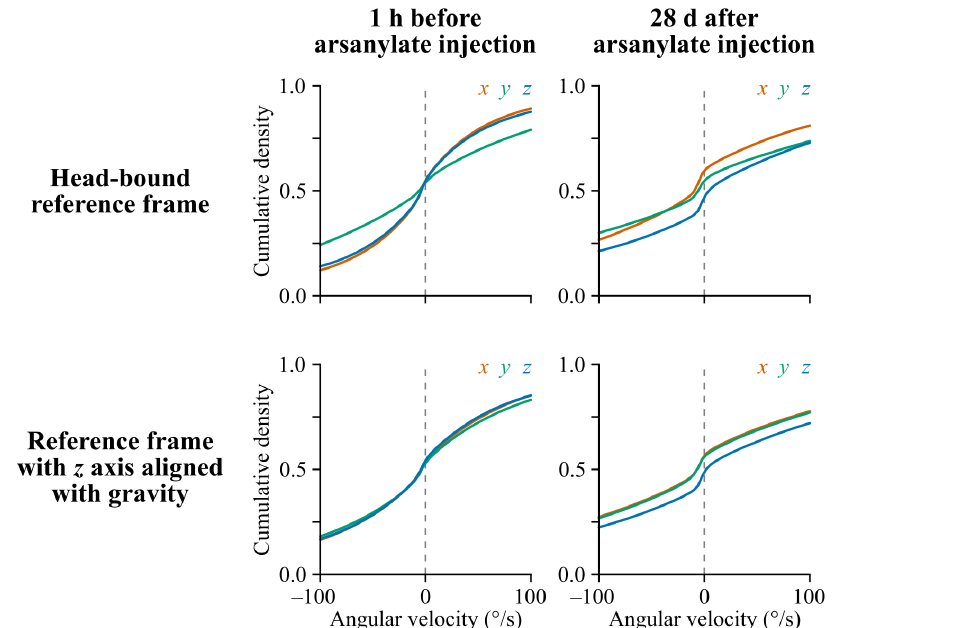
Figure A5. Per axis cumulative angular velocity distributions in a head-bound vs. a gravity-aligned reference frame before and after arsanilate injection into the left inner ear (example from one rat). In basal conditions, the distribution of pitch rotations (green curve) reaches larger values than roll and yaw rotations (top left panel). The arsanilate lesion induces a change in head kinematics, with a shift of yaw rotations in the counter-clockwise direction (a shift of the blue curve toward the bottom) which is most apparent when angular velocity values are expressed in a gravity-centered reference frame (with a z axis aligned with gravity and an x axis aligned with the animal’s nose by convention) as seen in the bottom right